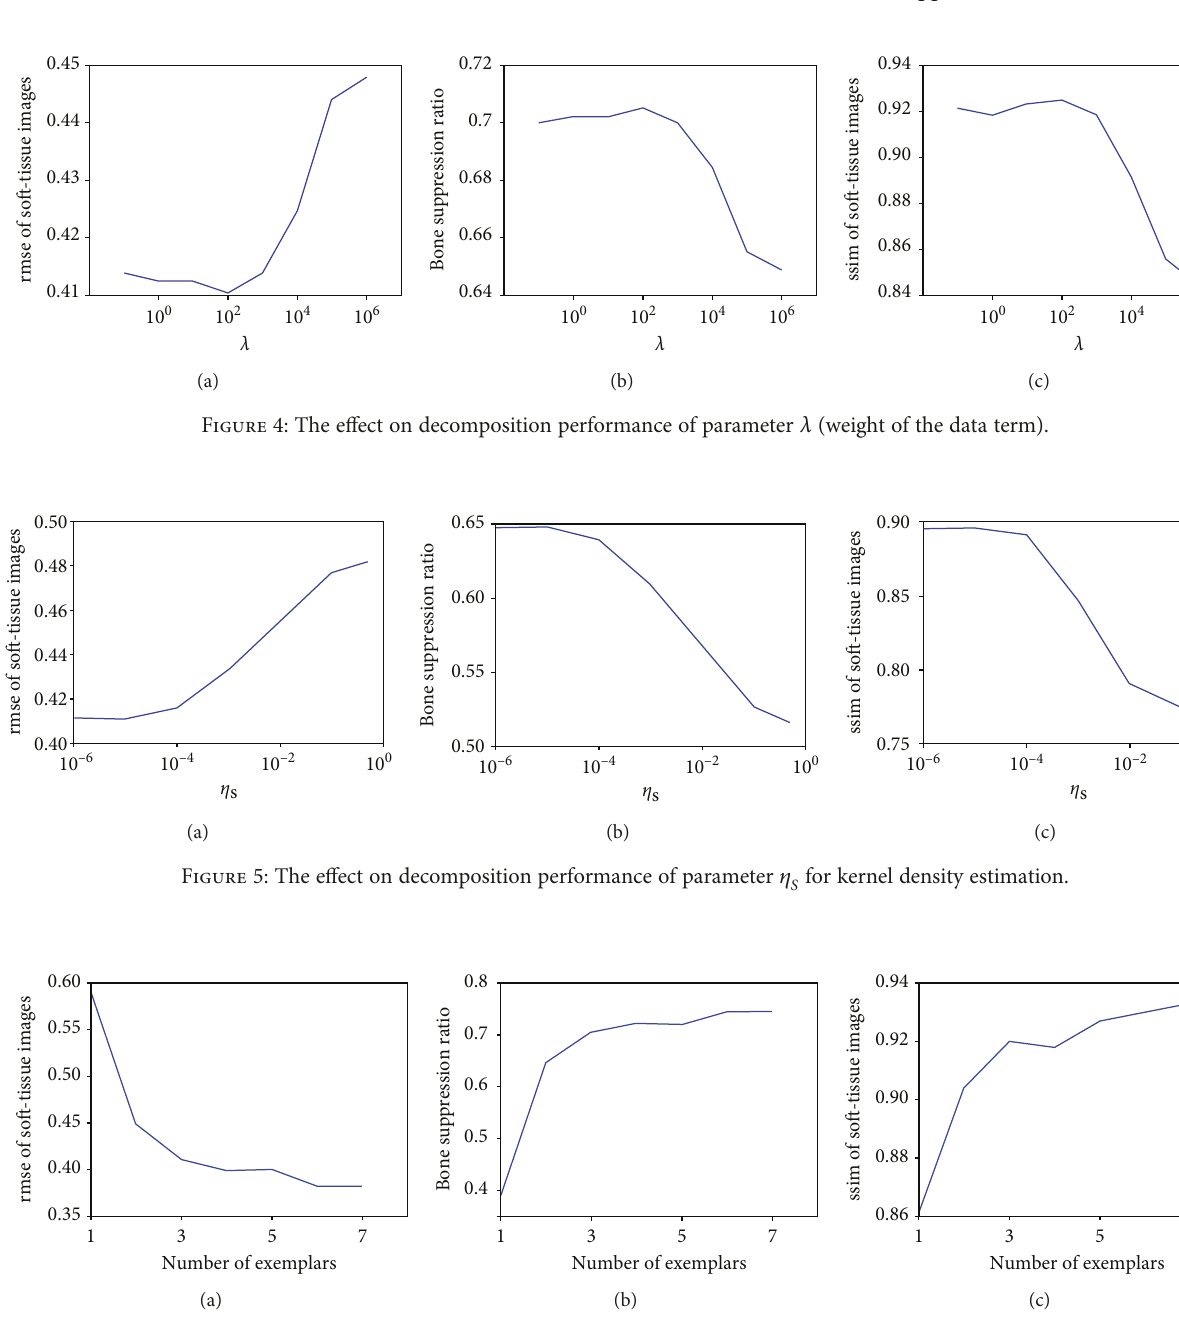
Figure 6: The e ff ect on decomposition performance of the number ( M